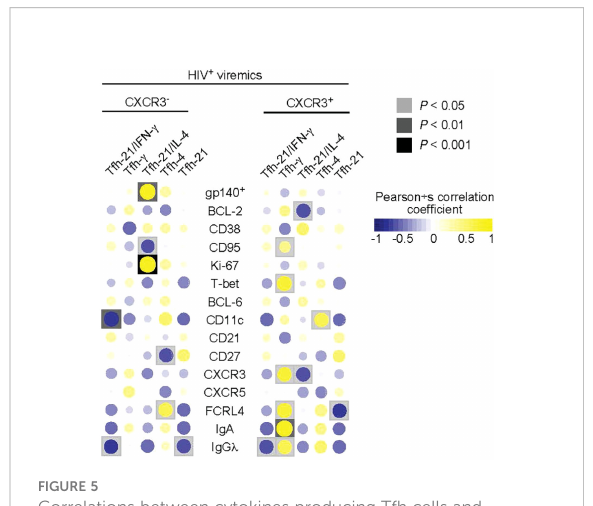
FIGURE 5 Correlations between cytokines producing Tfh cells and frequency and phenotype of gp140 speci fi c B cells. Correlative heat maps between the frequency of cytokines produced by Tfh cells from HIV infected viremic individuals and the proportion of gp140 speci fi c B cells and their phenotype (N = 11). Correlative analyses were performed on log10 transformed frequencies using Pearson ’ s